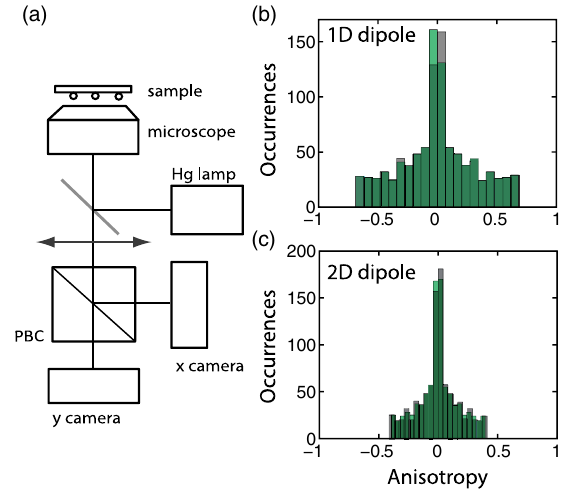
FIG. 3. (a) Schematic of the setup. A polarizing beam-splitter cube (PBC) is placed in front of two CCD cameras (directions x and y). (b) and (c) Distribution of the anisotropy A ¼ð I x − I Þ = ð I þ I Þ simulated for randomly oriented 1D dipoles and y x y 2D dipoles. Calculations are performed for situation (ii), with n ¼ 1 . 5 , n ¼ 1 , d ¼ 50 nm, λ ¼ 620 (grey) and 565 nm (green) 1 2 and a 1.4 numerical